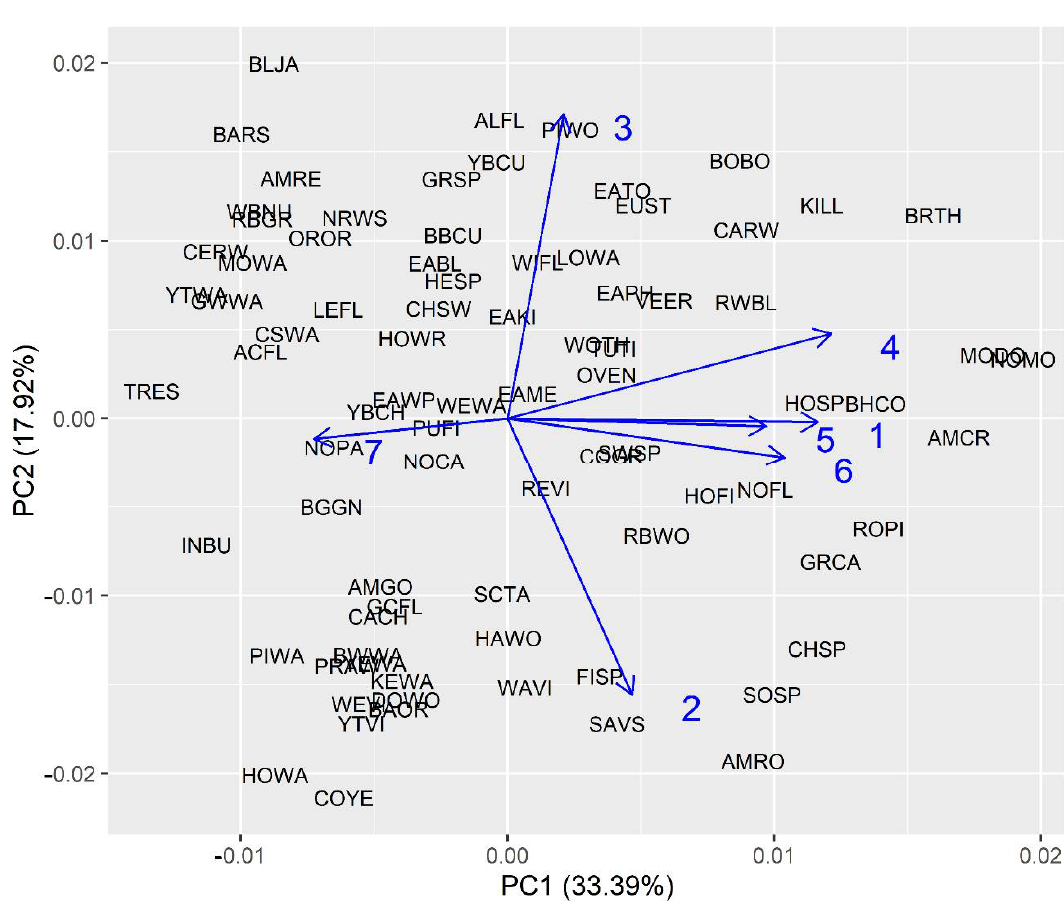
Figure 3. Distance biplot of the first and second principal components describing human preferences for the traits of forest generalist and edge/open country songbird species. Species are labelled by their alpha code [56,57] (Table S1). Variables are foraging behavior (1), primary color (2), secondary color (3), body size (4), dietary habit (5), cultural importance (6), and migratory behavior (7).